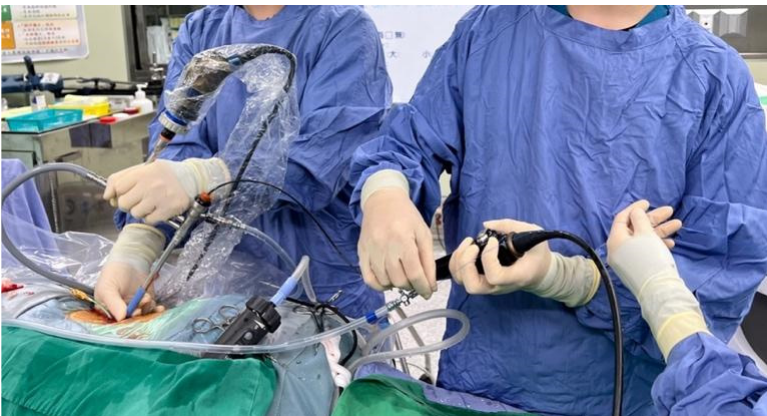
Figure 2. Operational assistance ( left side) held the nephroscope, and the experienced endourologist ( right side) performed flexible ureteroscopy.